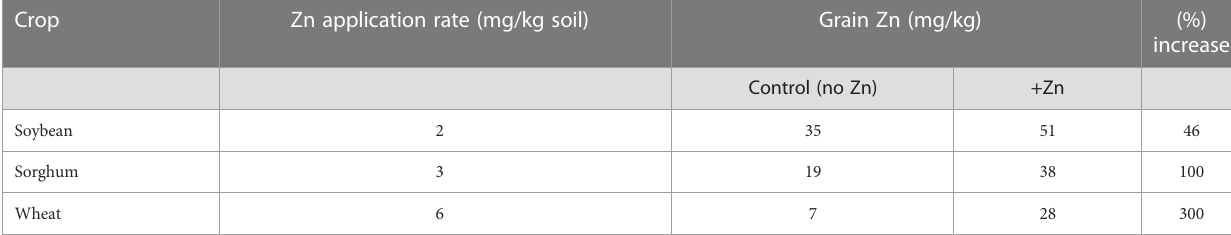
TABLE 1 Relationship between Zn application (soil) rate and grain Zn in different crops (data adapted from Dimkpa et al., 37- 39).